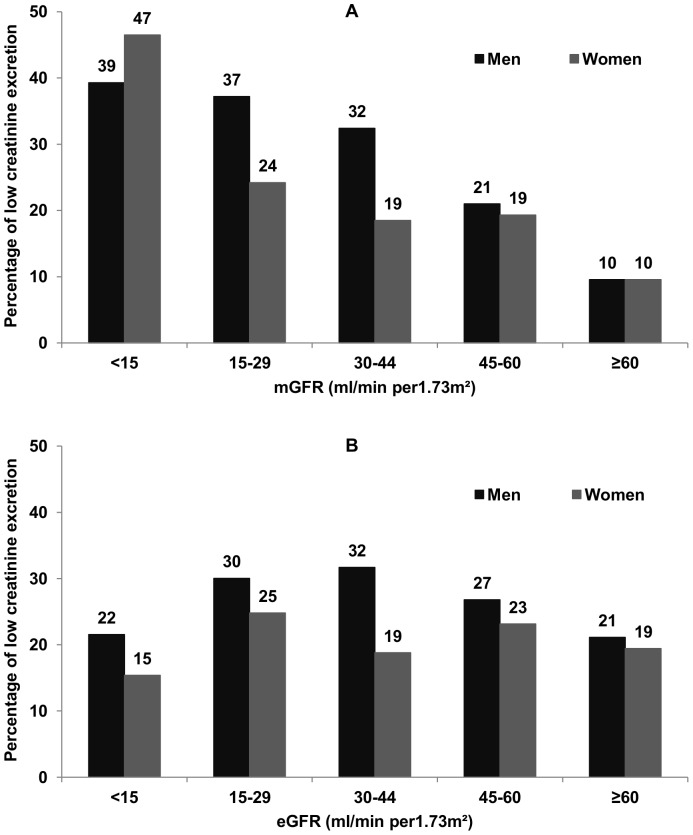
Percentages of low urinary creatinine excretion according to mGFR and eGFR level, by gender.Figure shows the percentage of patients with low creatinine excretion rates according to both measured (2A) and estimated (2B) glomerular filtration rate classes in men and women. Gender-specific thresholds were defined as the 10th percentile of the urinary creatinine distribution in patients with mGFR ≥60 mL/min/1.73 m2.